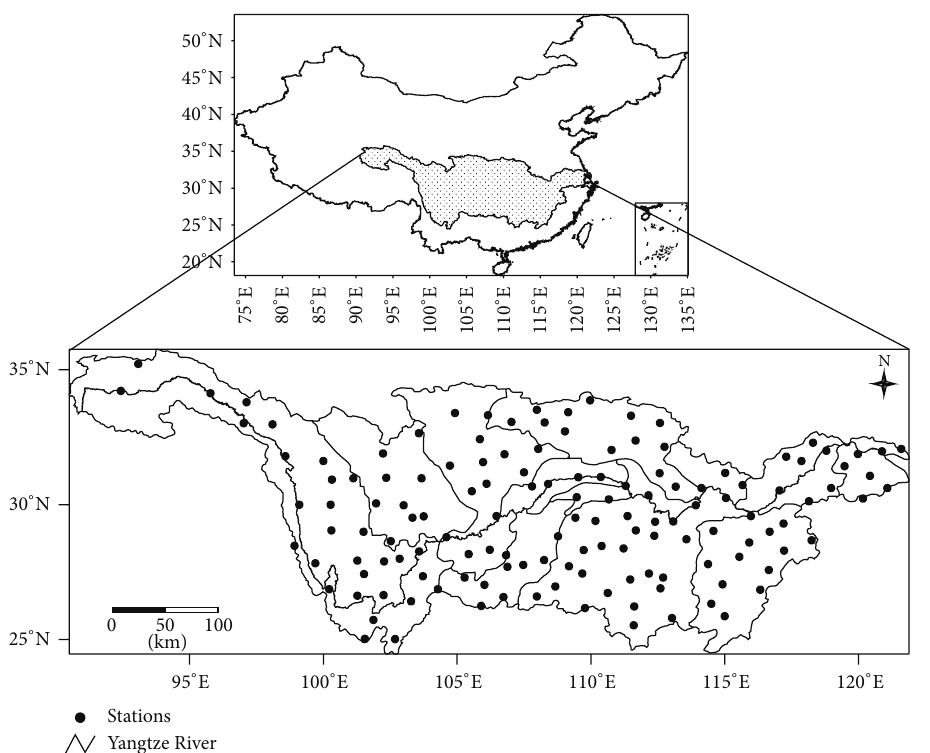
Figure 1: The location of Yangtze River basin and the location of the meteorological stations.